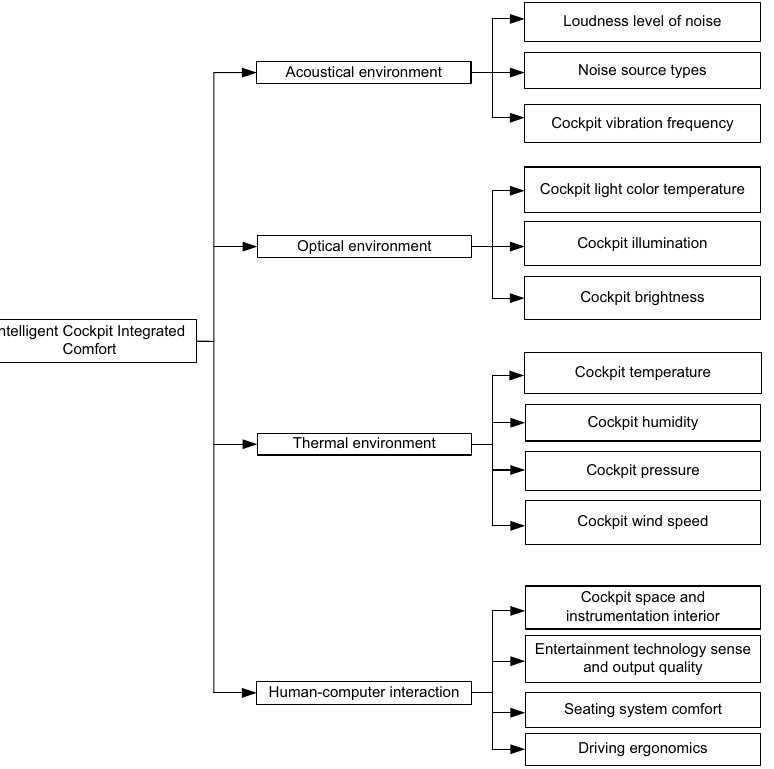
Figure 1. Comprehensive evaluation index system for impact of intelligent automobile cockpit